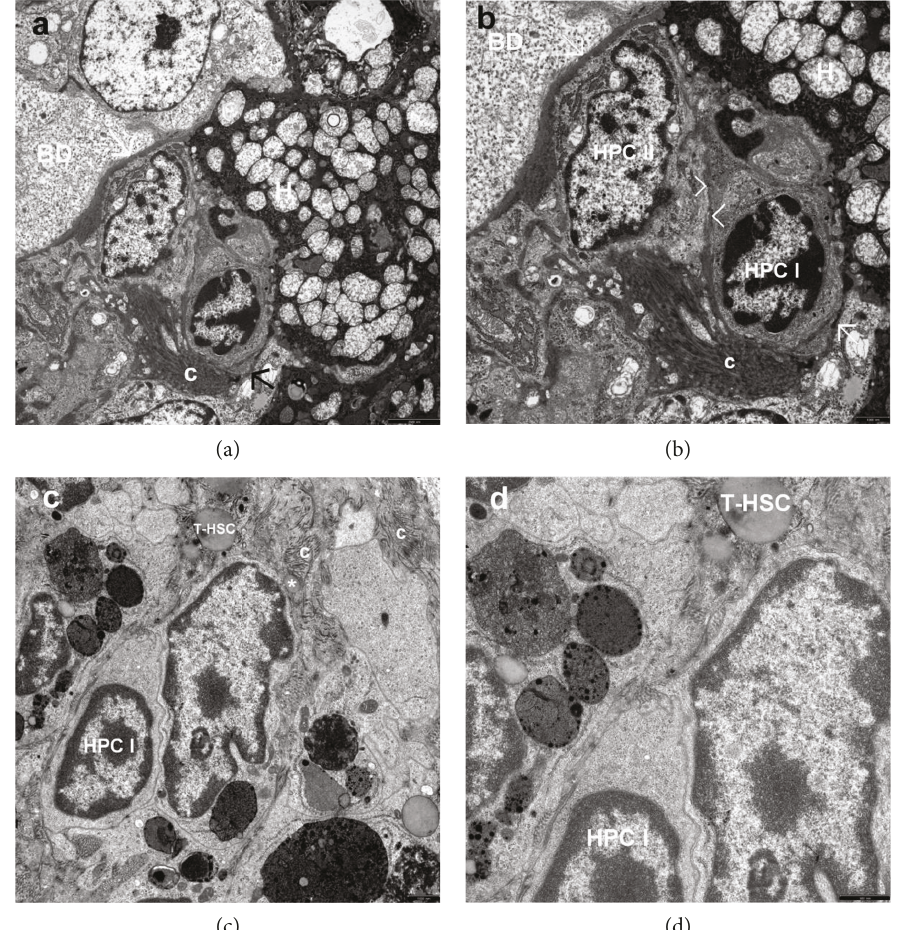
Figure 2: (a – d) Electron micrographs showing the periportal area of the hepatic lobule 6 weeks after inducing BDL in rats. (a) The picture of the neoforming oval cell ductule. Two HPCs (HPC I, HPC II) form the growing bile ductule in a close vicinity of the limiting plate of the hepatic lobule. These two cells are surrounded mostly by the basement membrane ( → ) that terminates on the periportal hepatocyte (H) showing severe mitochondrial degeneration. The basement membrane of the type II HPC is not discernible, and it seems that the cell is in contact with the collagen fi ber. The HPC I (the ductal blast-like cell) adheres tightly to the adjacent cells, by tight intercellular junctions to the type II HPC (the bile duct-like cell), and to the degenerated hepatocyte. A thick bundle of collagen fi bers (c) surrounds a neoforming ductular structure; in places, the bundle almost penetrates the structure. In the vicinity, a fragment of the already formed bile ductule (BD). Scale bar, 2.5 μ m, original magni fi cation × 4400. (b) Higher magni fi cation shows tight intercellular junctions ( > ) between two types of HPCs of the neoforming bile ductule. Scale bar, 1 μ m, original magni fi cation × 12000. (c) The picture of undi ff erentiated HPC I — very primitive-looking cell with tightly enclosing Kup ff er cells/macrophages; a process of T-HSC adheres to the upper pole of HPC I; at a short distance, a very fi ne degenerated HSC ( ∗ ) enclosed by collagen fi bers (c). Scale bar, 1 μ m, original magni fi cation × 12000. (d) Higher magni fi cation well demonstrates contact HPC I with T-HSC and with Kup ff er cells. Scale bar, 0.5 μ m, original magni fi cation ×